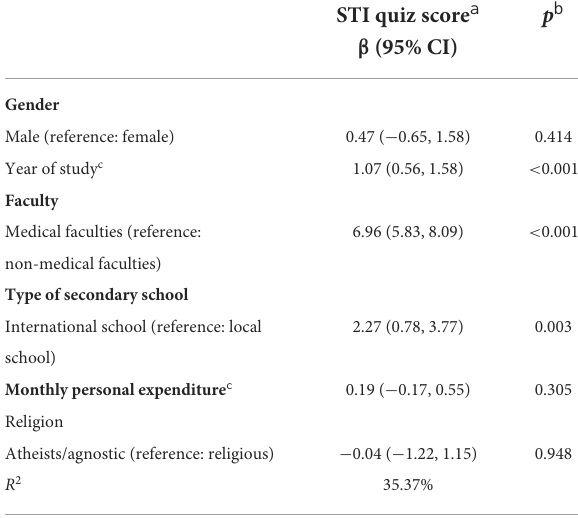
TABLE 4 Association between sexually transmitted infection quiz score and parameters of previous sex education and attitudes toward sexual health